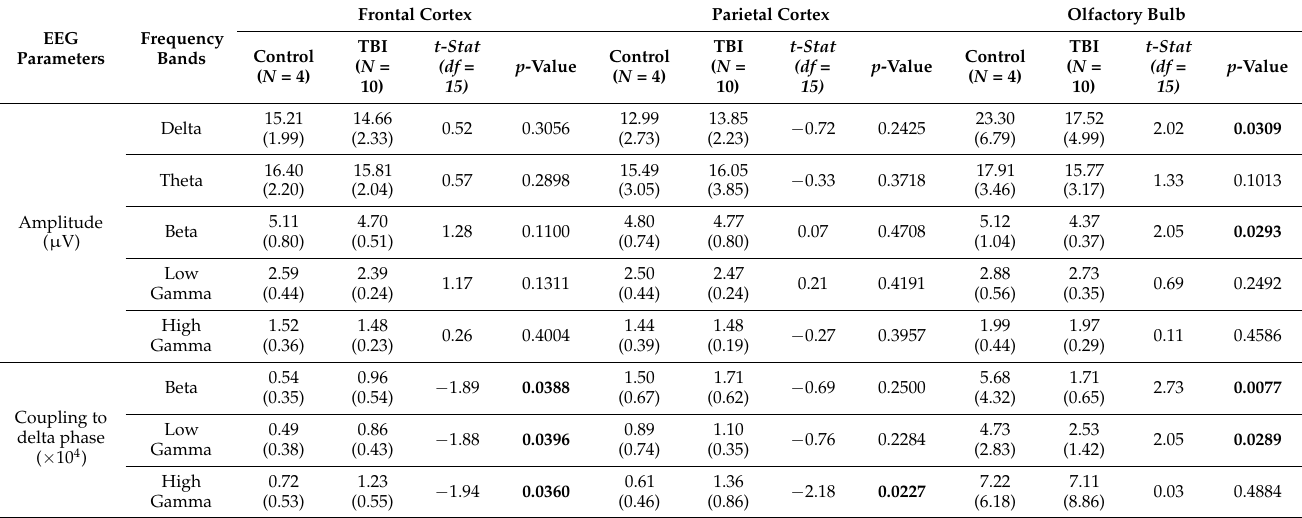
Table 1. Summary of spontaneous oscillation and modulation by delta